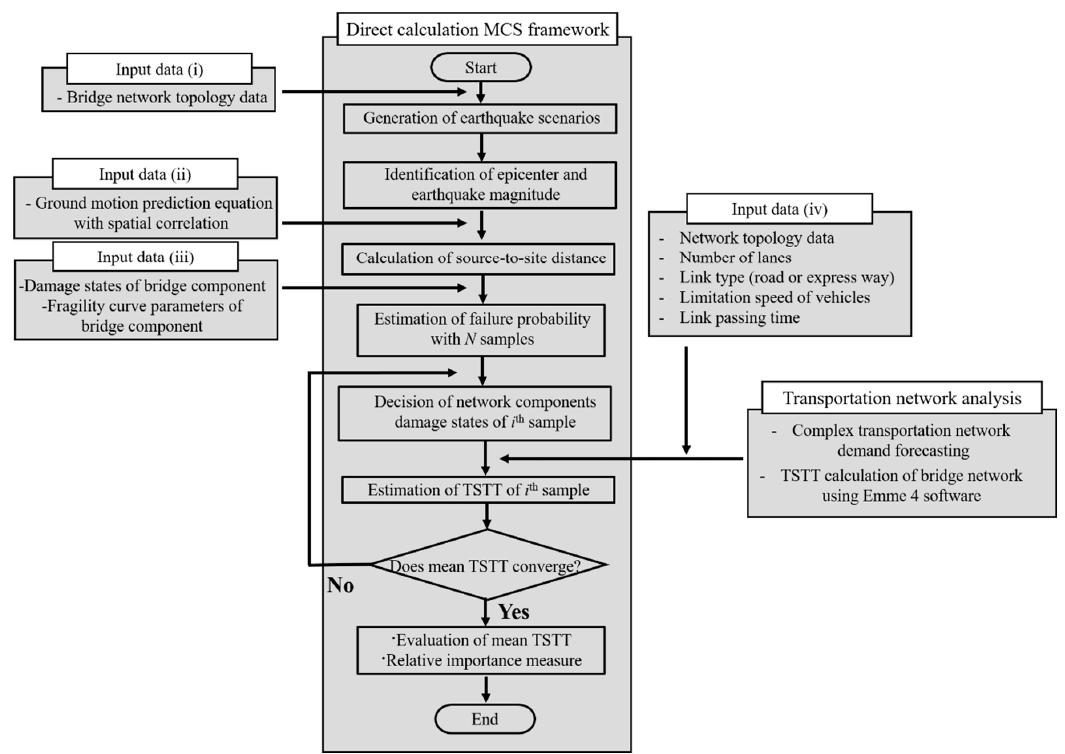
Figure 1. Conventional Monte Carlo simulation (MCS) framework for direct calculation.